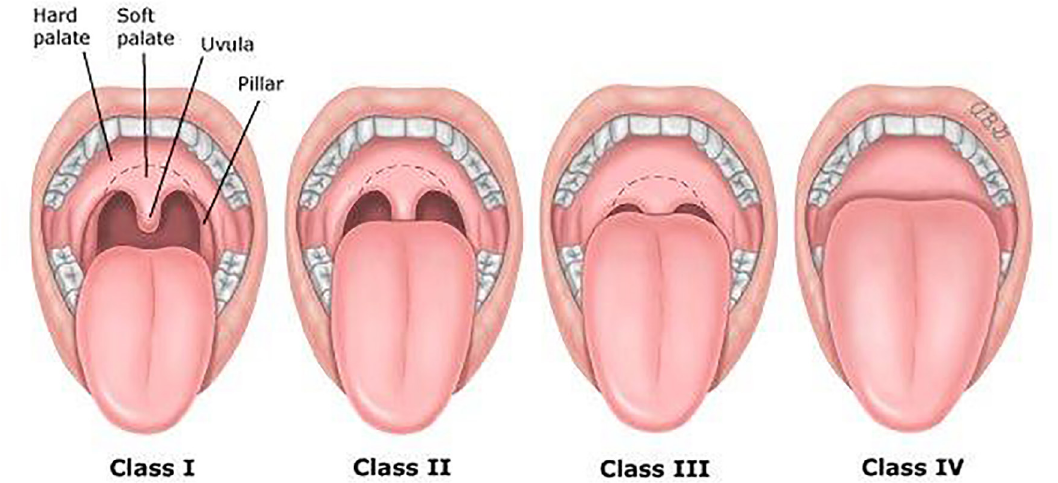
Figure. The modified Mallampati classification